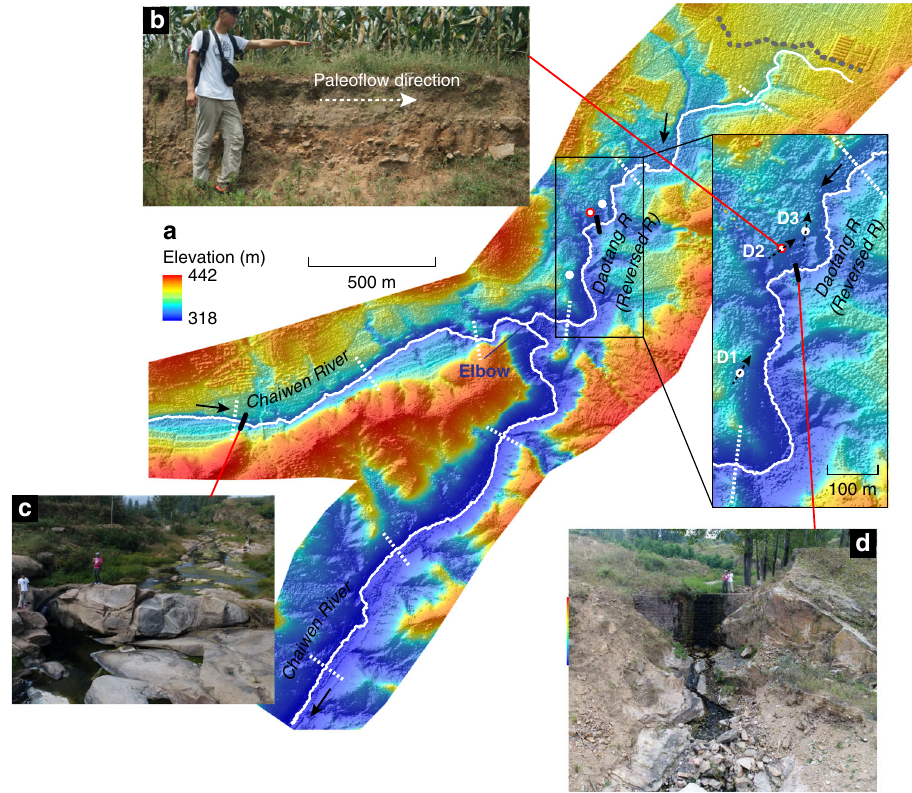
Fig. 2 A close-up of the study area. a Shaded relief map with a resolution of 0.5 m covering the area close to the elbow produced using an Unmanned aerial vehicle (UAV) (see Methods). White dots represent locations for D1, D2, and D3 where the dip directions of imbricated cobbles were measured (see Fig. 3 for rose plots) and the median paleo- fl ow directions indicated by the cobbles are shown as black dashed arrows, opposite of the present fl ow direction of Daotang River. Black bars denote the location for the two waterfalls and gray dashed line denotes the wind gap. Dashed white lines indicate the traces of cross-sectional pro fi les shown in Supplementary Fig. 1. b A deposit in an old terrace looking west where the dip directions of the imbricated cobbles were measured (D2). The guy in the image provides a rough scale. c The 2.2 m high knickpoint in Chaiwen River. d The 10 m high knickpoint in the Daotang River